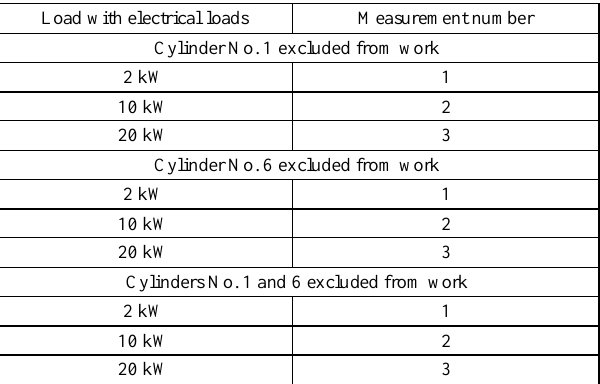
Table 2. Study plan for DG in full technical